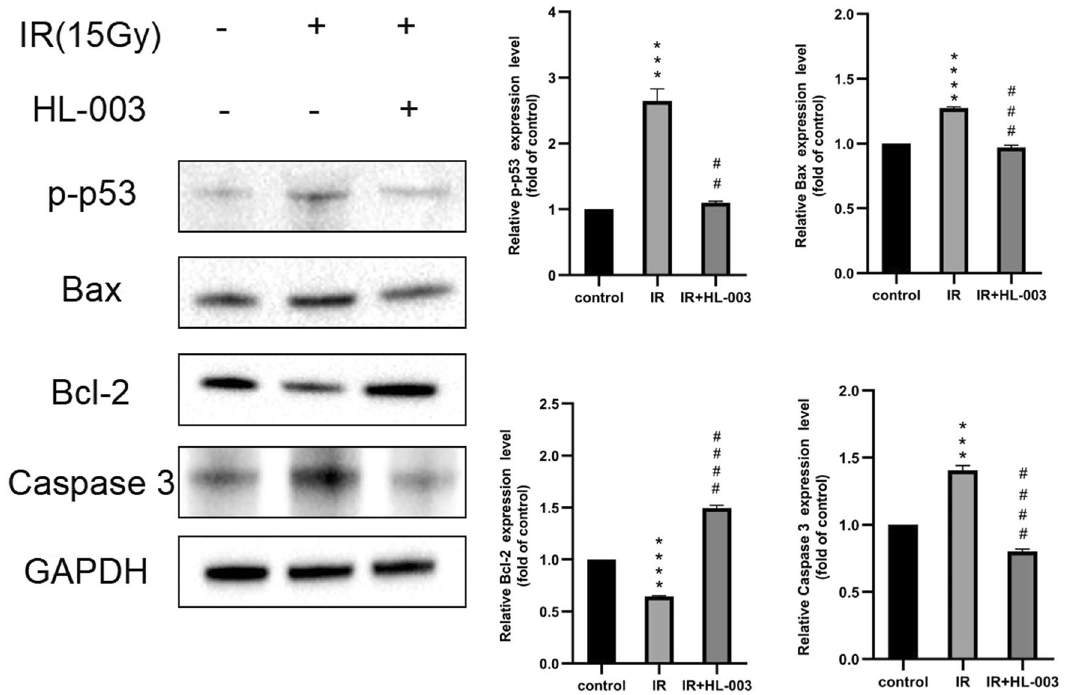
Figure 6. HL-003 suppresses apoptotic signaling pathway. Western blot analysis of p-p53, Bax, Bcl-2 and caspase 3. Relative quantitative analysis is shown. Each bar shows the mean ± SEM; ***p < 0.001, ****p < 0.0001, compared with the control group; ## p < 0.01, ### p < 0.001, #### p < 0.0001, compared with the IR group (n = 6 per